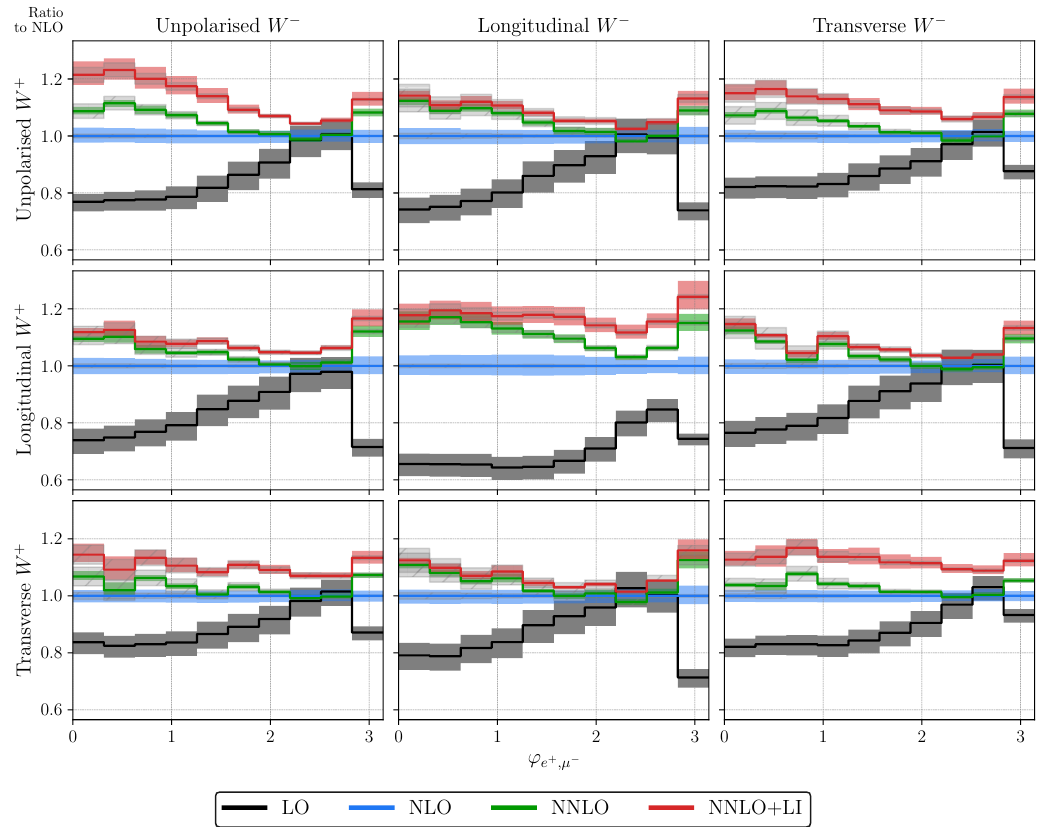
Figure 9 . Ratio to NLO of azimuthal separation between charged leptons at various orders of perturbative QCD. Same plot structure as in figure